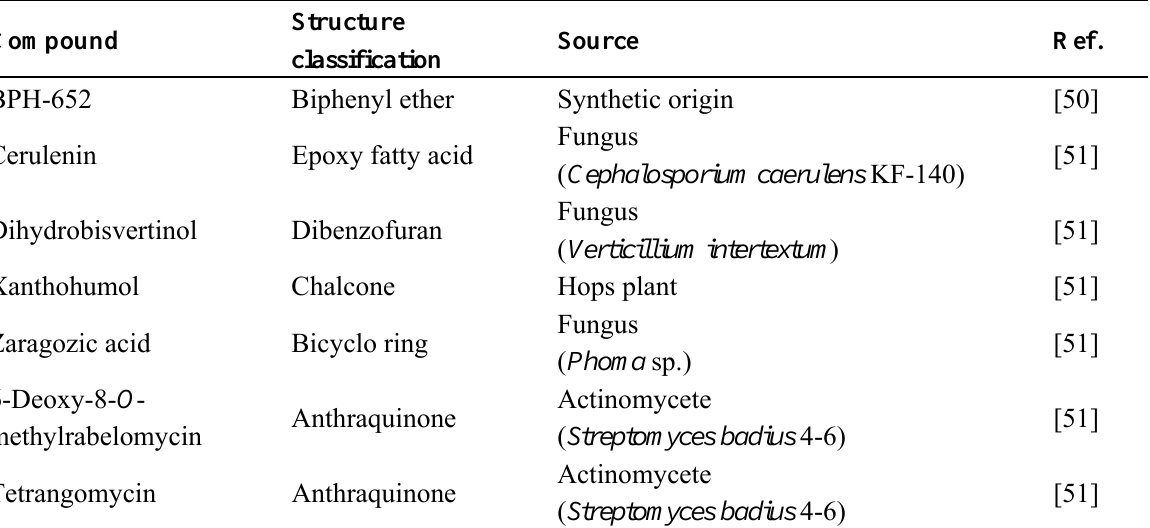
Table 3. Inhibitors of staphyloxanthin biosynthesis in S. aureus .